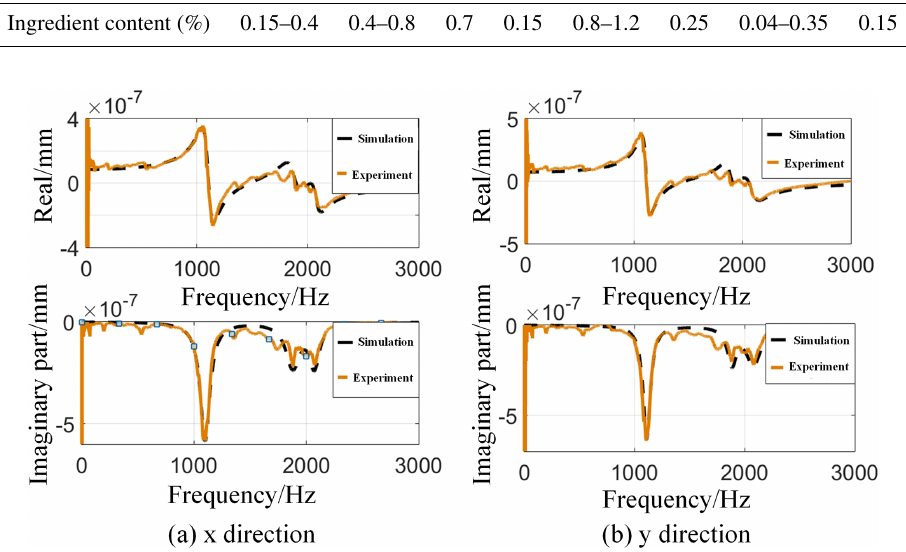
Figure 3. Frequency response functions of the tool in the x and y directions.